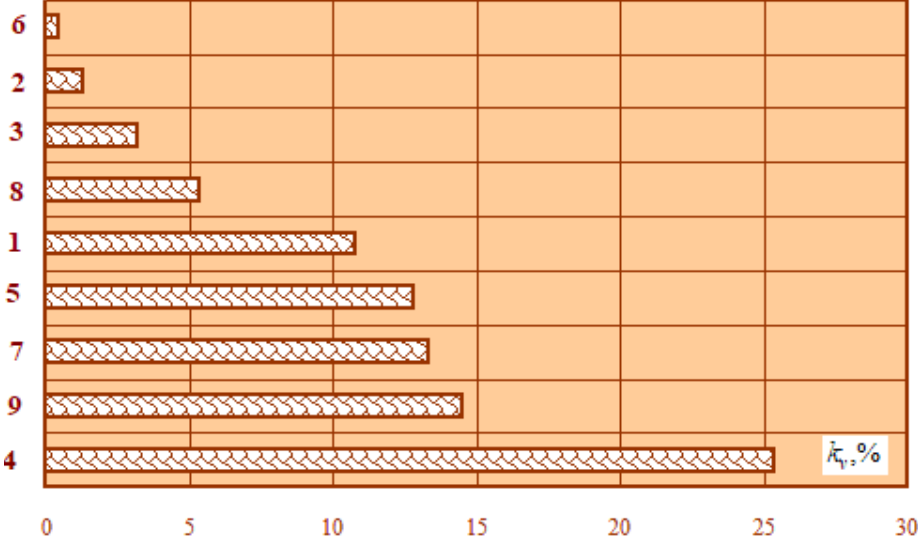
Figure 24. Coefficients of variation of magnetic field amplitudes—the callout numbers correspond to